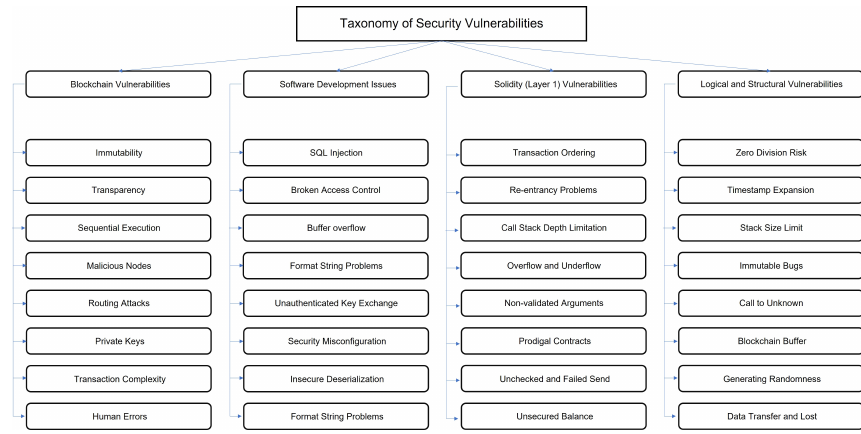
Figure 5. Taxonomy of smart contract security